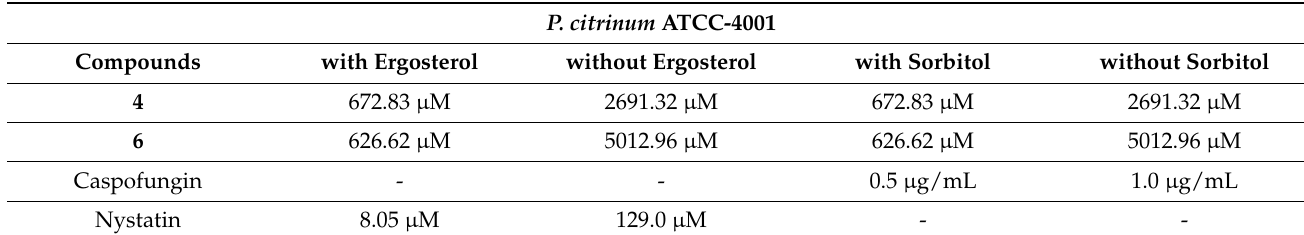
Table 4. Effects of compounds 4 and 6 in the presence or absence of a protective osmotic (sorbitol 0.8 M), as well as in the presence or absence of ergosterol, against the strains of P. citrinum